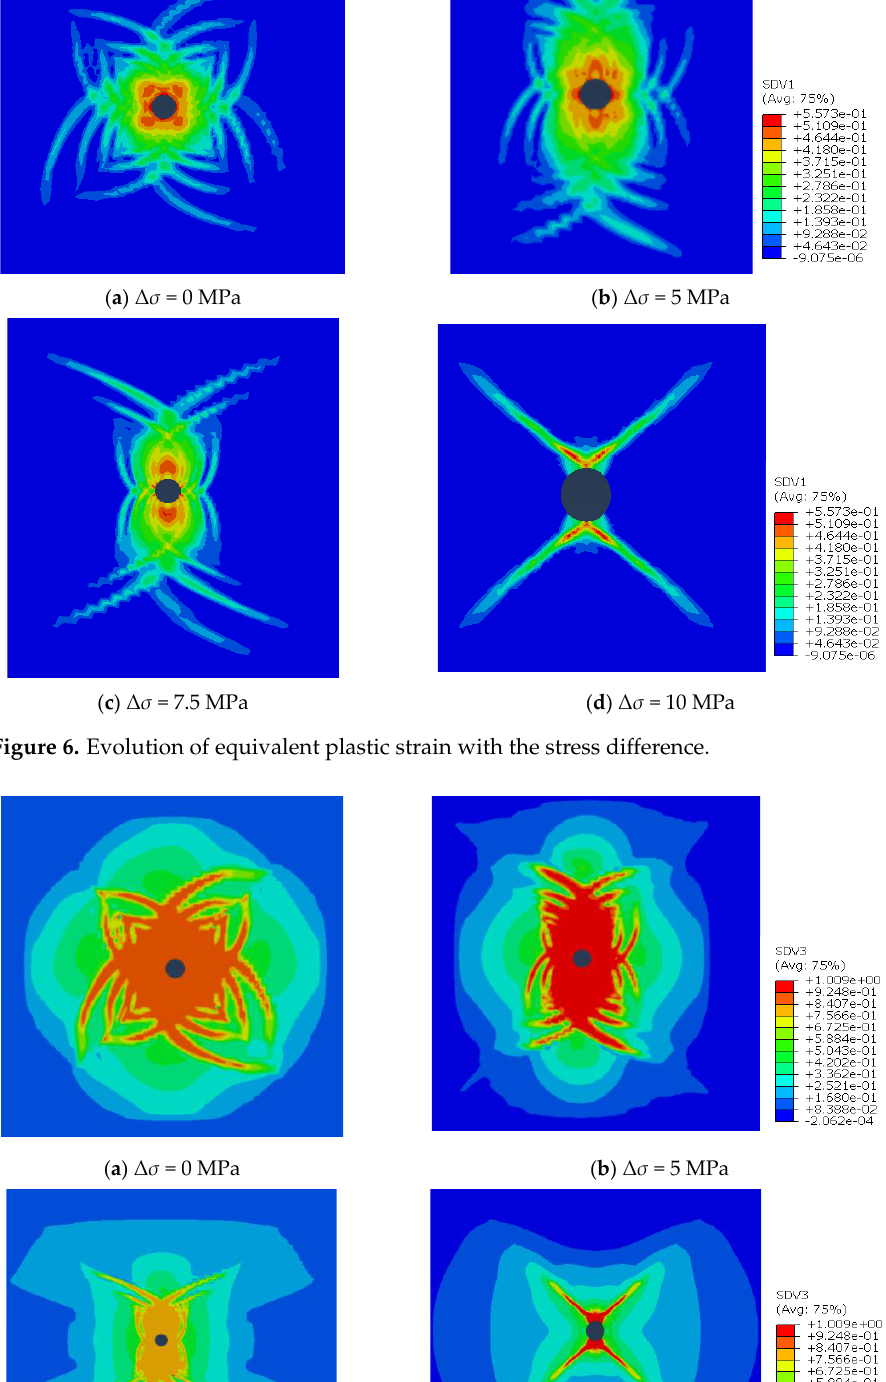
( b ) Disturbance damage factor 0 . 0